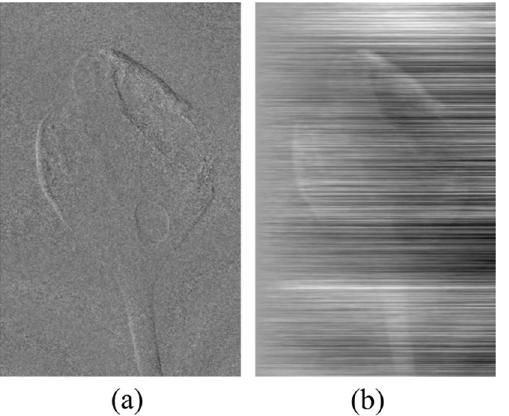
Figure 1. The phase images from grating interferometer. ( a ) The differential phase contrast image, ( b ) the retrieved phase image using direct integration.